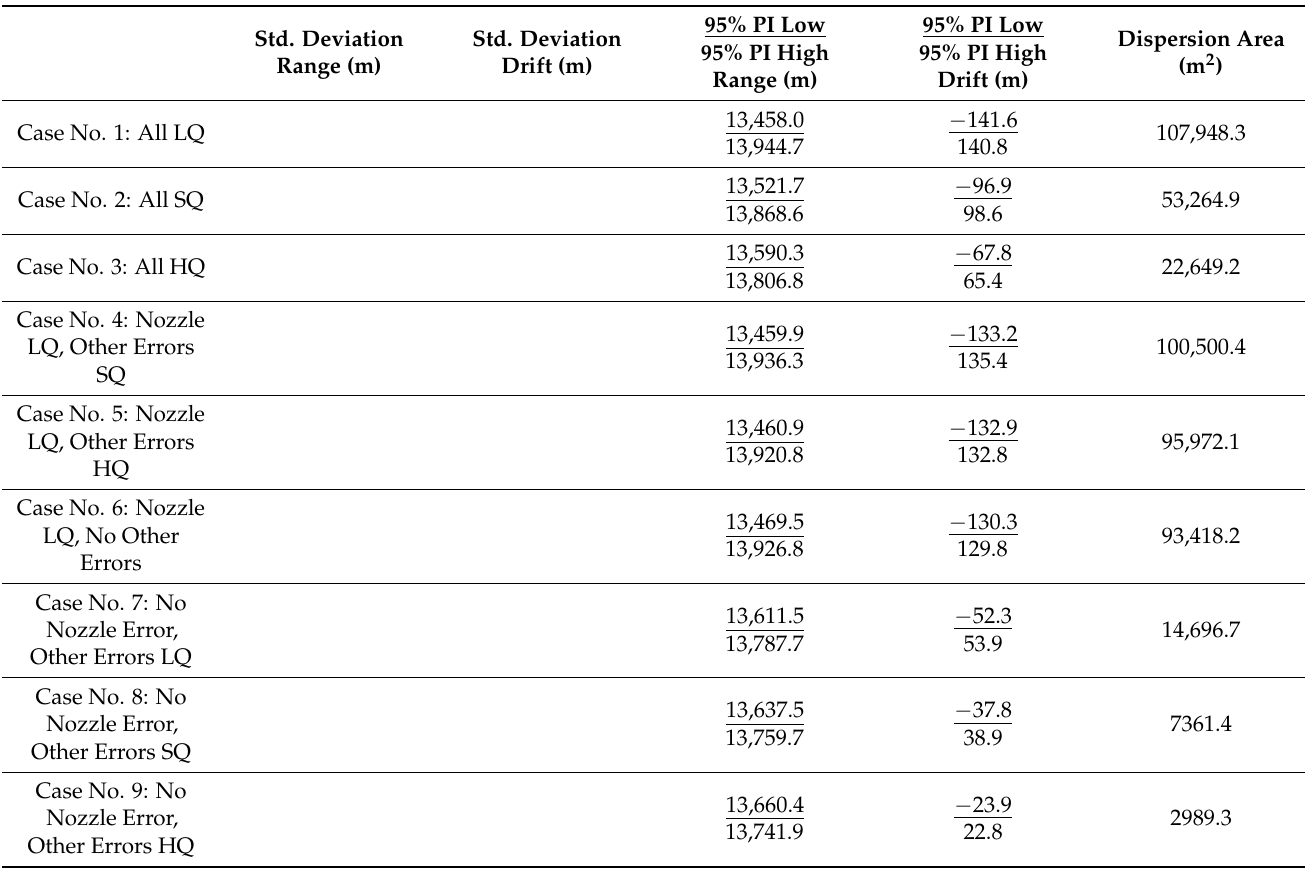
Table 4. The comparison of standard deviations for nine analyzed